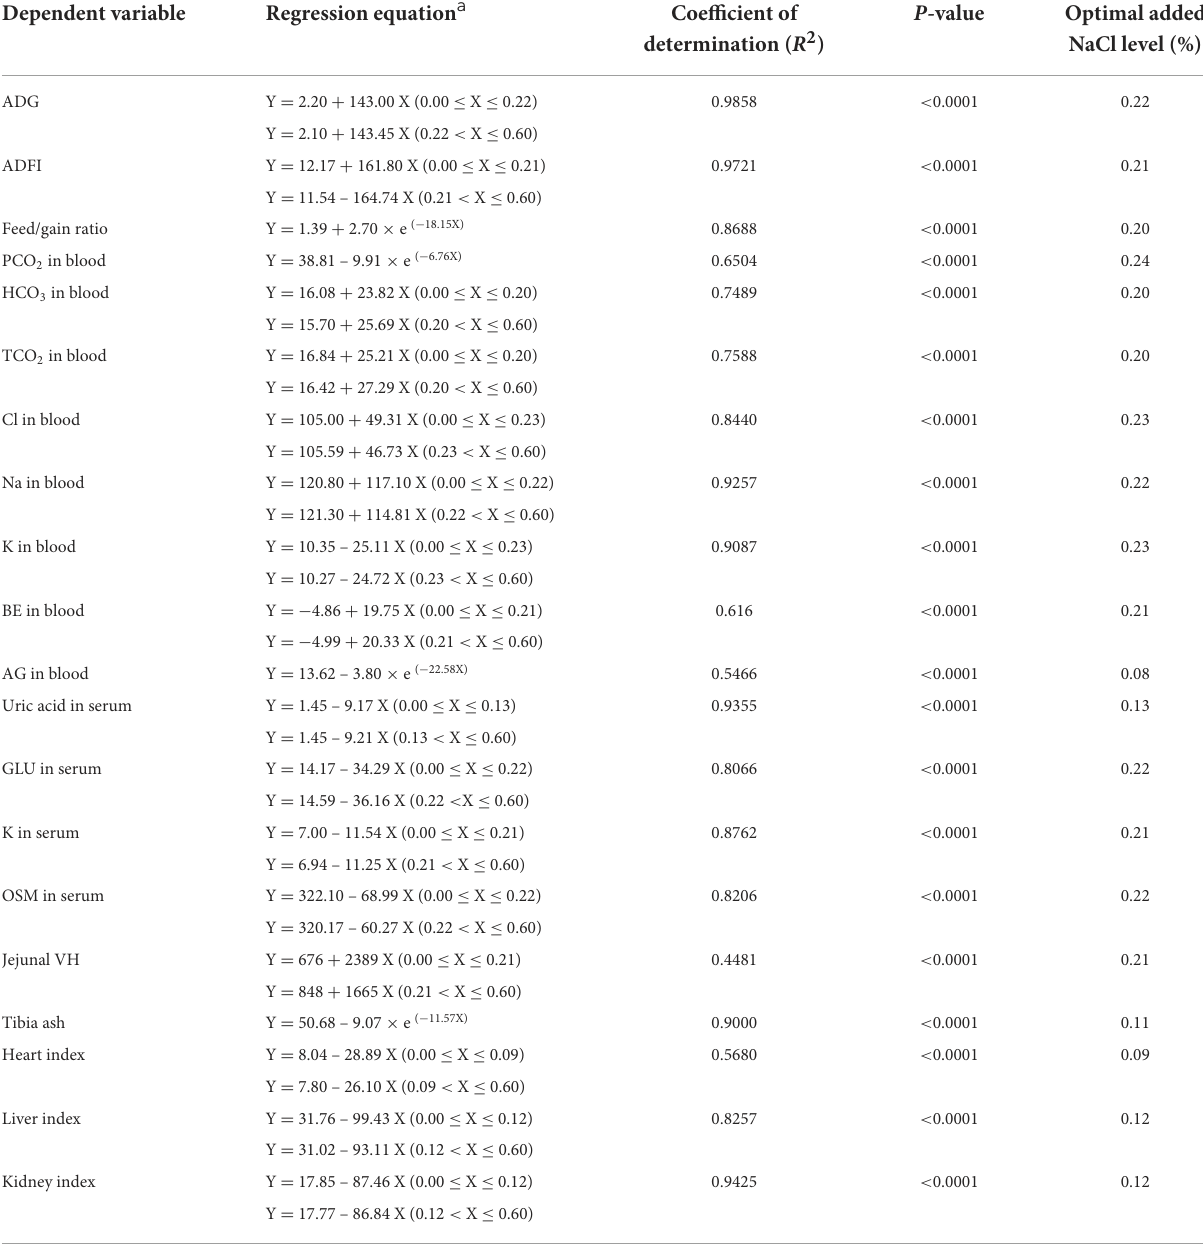
TABLE 7 The optimal dietary NaCl levels of chicks during 1–21 days of age as estimated based on the best fitted broken-line or asymptotic models. Dependent variable Regression equation a Coefficient of